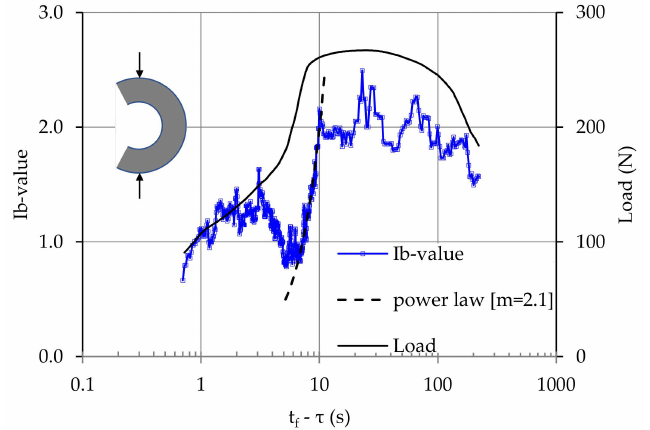
Figure 13. The temporal variation of the Ib-value, together with the respective variation of the applied load, for a typical CSR